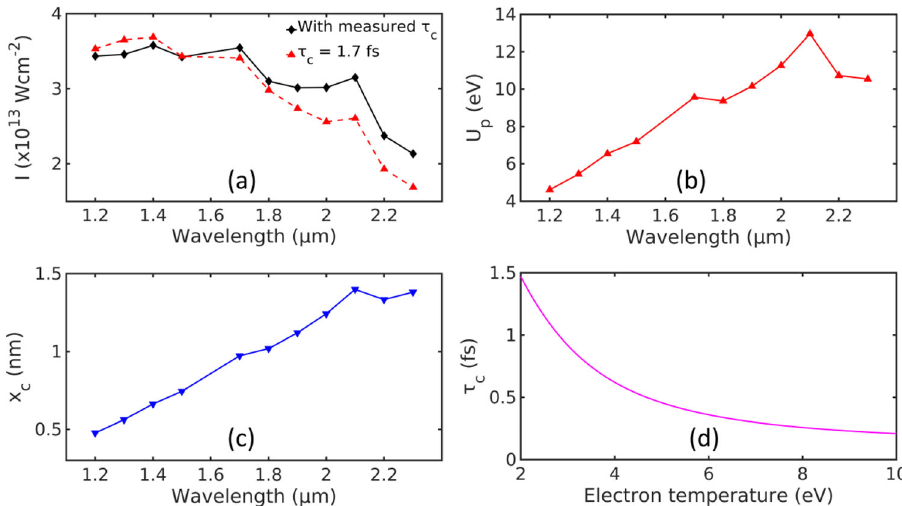
Fig. 5 Calculations of clamping intensities inside fi laments, ponderomotive energies, excursion lengths, and electron collision times. Calculated a clamping intensities with measured τ c ’ s and constant τ c ¼ 1.7 fs, b pondermotive energies ( U p ), and c excursion lengths ( x c ) are shown for fi lamentation at different wavelengths. d The calculated electron collision time as a function of electron temperature. Clamping intensities from simulations in a (black solid line) are used to calculate the ponderomotive energies in b and excursion lengths in c